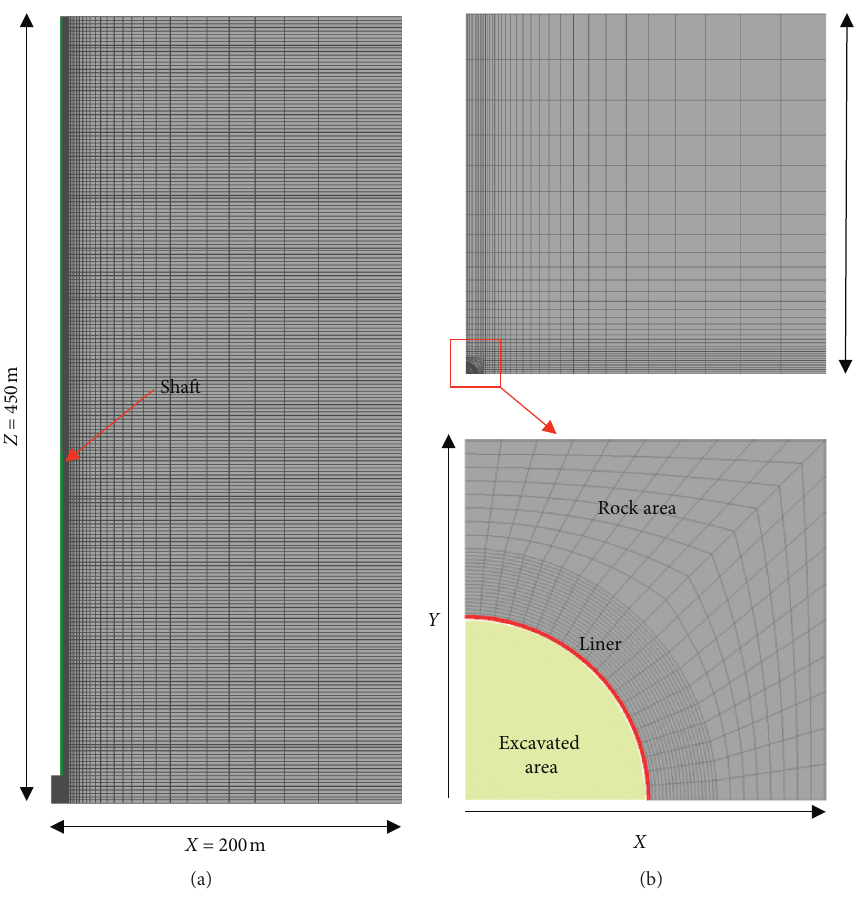
Figure 10: 3D vertical shaft model mesh